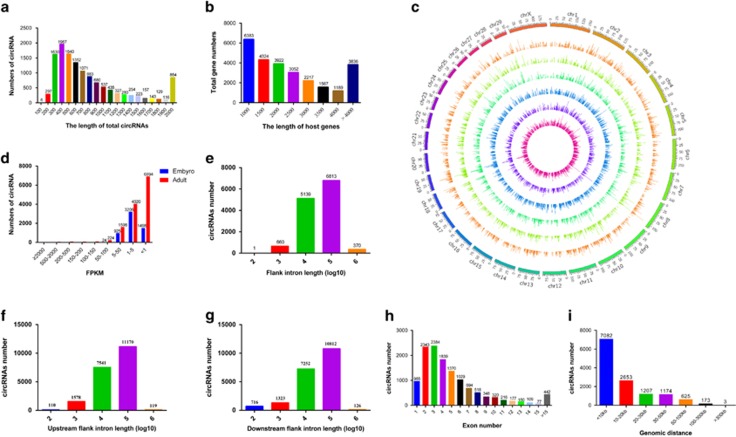
Profiling of circular RNAs in bovine skeletal muscle. (a) Size distribution of circRNAs and (b) of the respective host genes, (c) Circos plot showing the distribution of circRNAs in different chromosomes, (d) numbers of back-spliced reads in circRNAs, (e–g) lengths of flanking introns, and (h) circRNAs that contained varying numbers of exons. (i) Genomic distances of back-splicing sites of most circRNAs ranged within 50 kb, with only few circRNAs spanning 100–300 kb